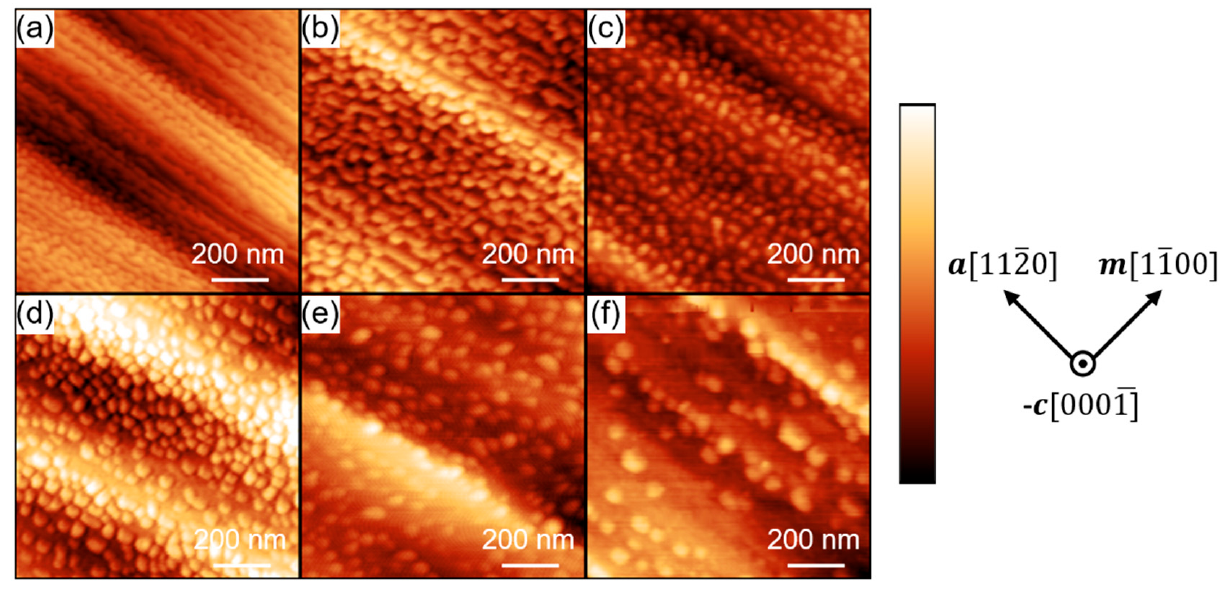
Figure 3. 1 × 1 µm AFM images of nominally 1 nm of N − polar InN grown at different temperatures. InN dash and wire − like structures are aligned along the a − direction. ( a ) 540 °C. ( b ) 560 °C. ( c ) 580 °C. ( d ) 600 °C. ( e ) 620 °C. ( f ) 640 °C. Vertical scale bar is 0–20 nm for ( a ) and 0–10 nm for ( b – f ).